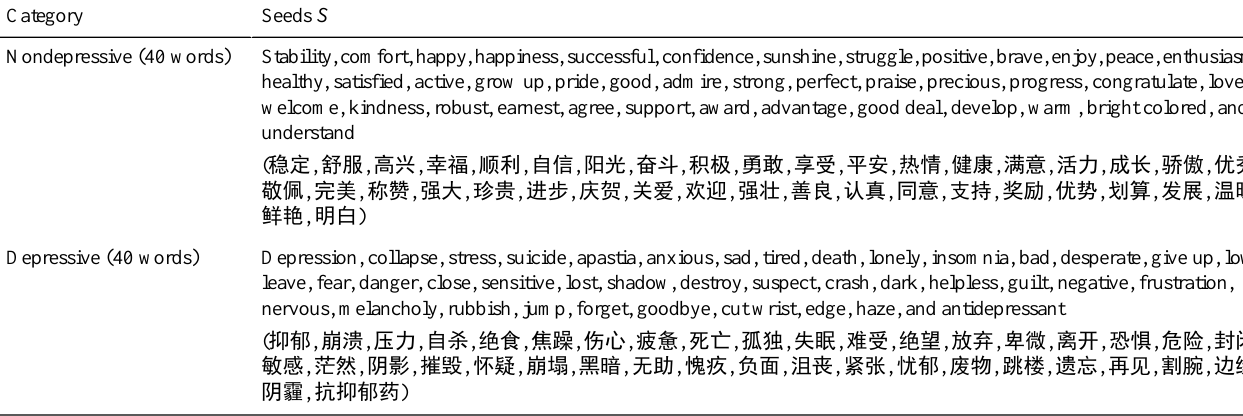
Table 3. Summary of the seeds.